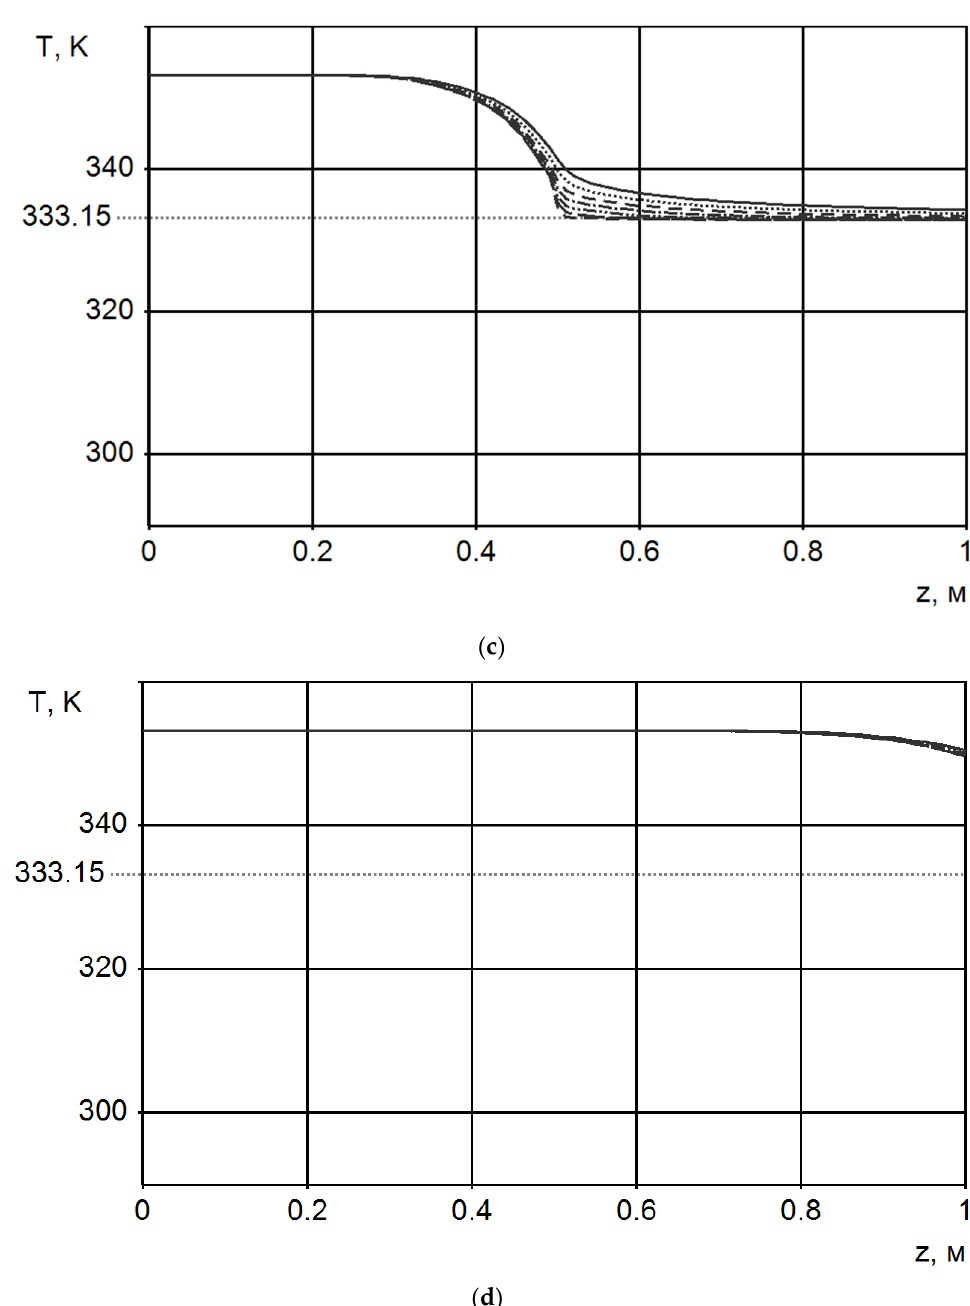
Figure 3. Longitudinal and transverse temperature profiles in PCM calculated for various points in time τ after starting the water flow: ( a ) τ = 10 s; ( b ) τ = 50 s; ( c ) τ = 150 s; ( d ) τ = 250 s. Different lines correspond to various distances from the axis: −− r = 7.5 mm; ∙∙∙∙∙ r = 8.5 mm; - - - r = 9.5 mm; − ∙ − ∙ r = 10.5 mm; − ∙ ∙ − r = 11.5 mm; − − − r = 12.5 mm; ─ ─ ─ r = 13.5 mm.